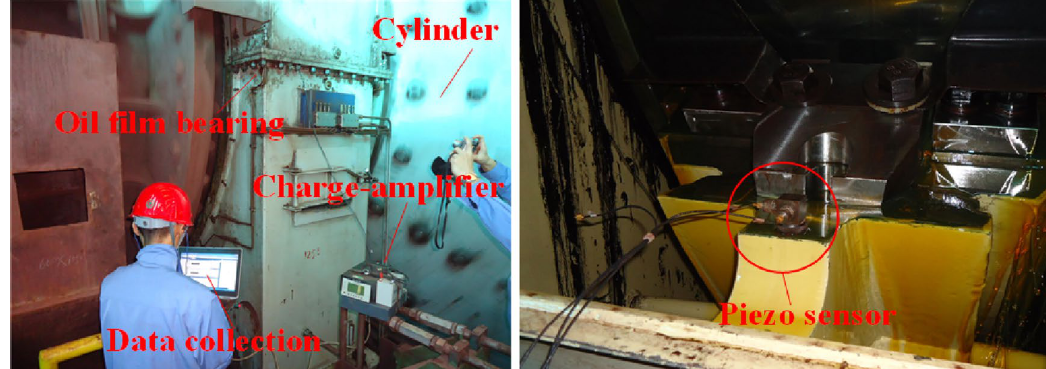
Figure 14. Field test diagram.